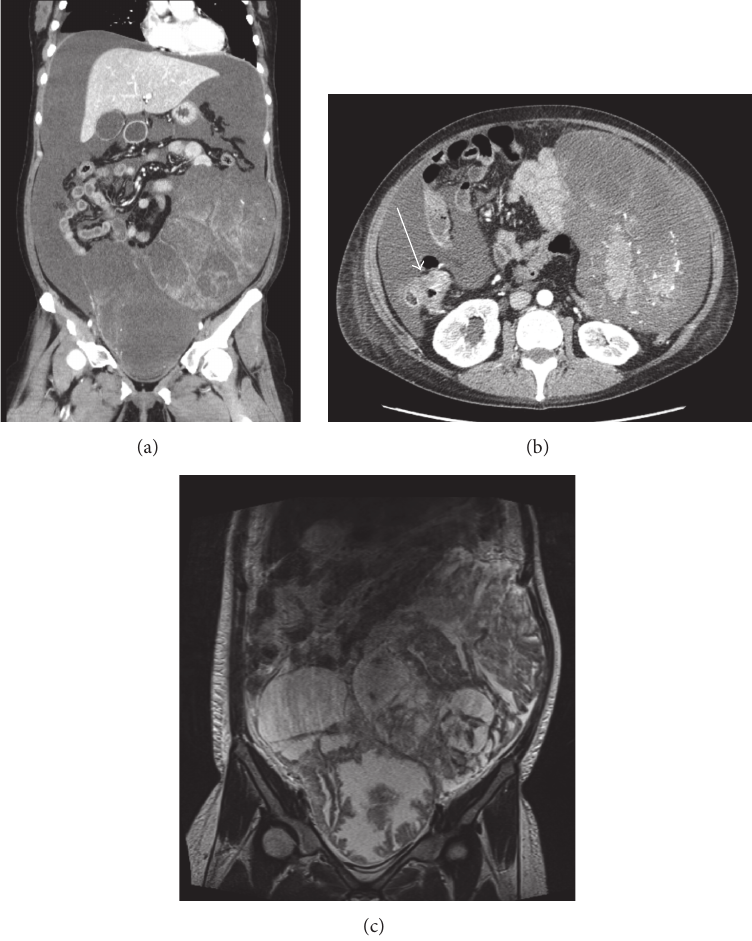
Figure 4: Case 2. Contrast-enhanced CT scan shows a well-circumscribed and heterogeneously enhanced tumor of the ovary ((a) coronal plane) and wall thickening of the ascending colon with enhancement (arrow; (b) axial plane). MRI T2 shows cystic masses in the pelvis ((c) coronal